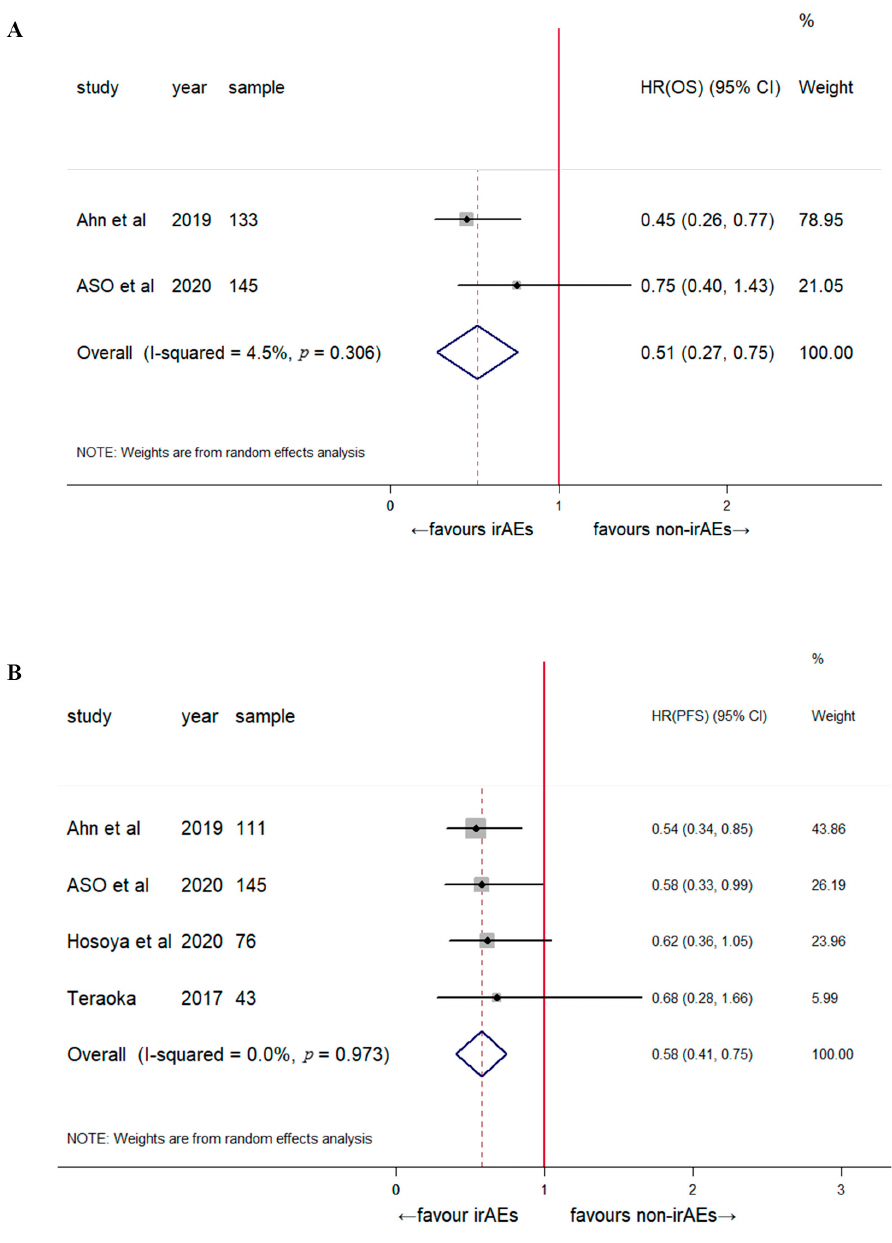
Figure 3. Subgroup analysis of the association between early-onset dermatological irAEs and the clinical outcome of patients treated with immune checkpoint blockade. Overall survival ( A ) [2,16] and progression-free survival ( B ) [2,14–16].